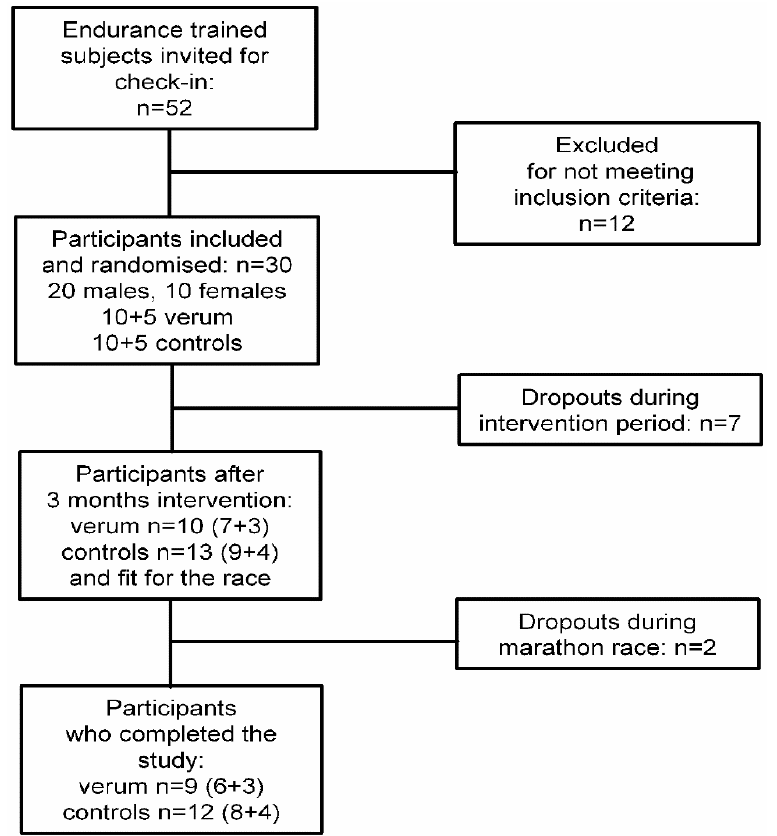
Figure 1. Study flowchart. Control group: endurance training intervention for 3 months. Verum group: endurance training plus protein-rich supplement for three months.